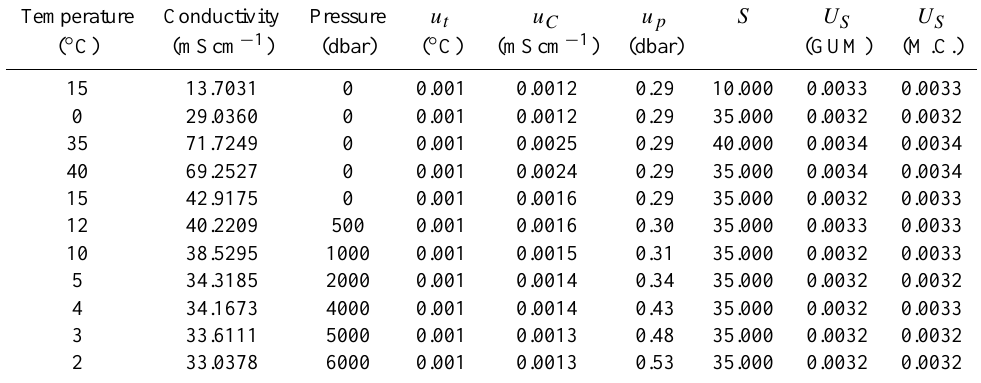
Table 4. Expanded combined uncertainties on salinity, computed with representative values of temperature, conductivity and pressure and their combined standard uncertainties. Conductivity combined standard uncertainties u C correspond to the values found in table 3 and for temperature, the standard uncertainty corresponds to the best case when u t = 0 . 001 ◦ C. Idem for u p